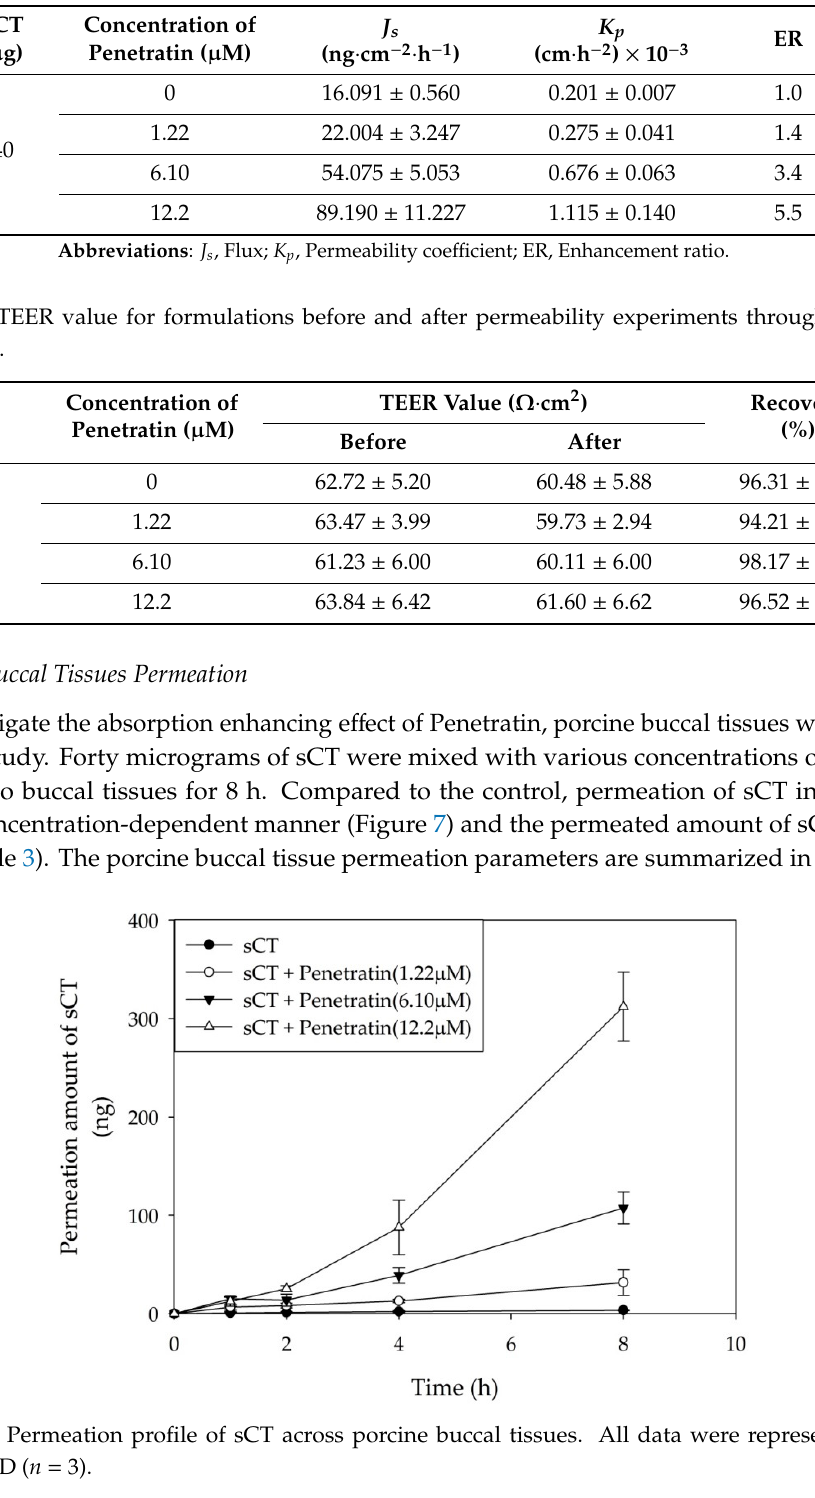
Table 1. Permeation parameters calculated from the TR146 cell permeation study.